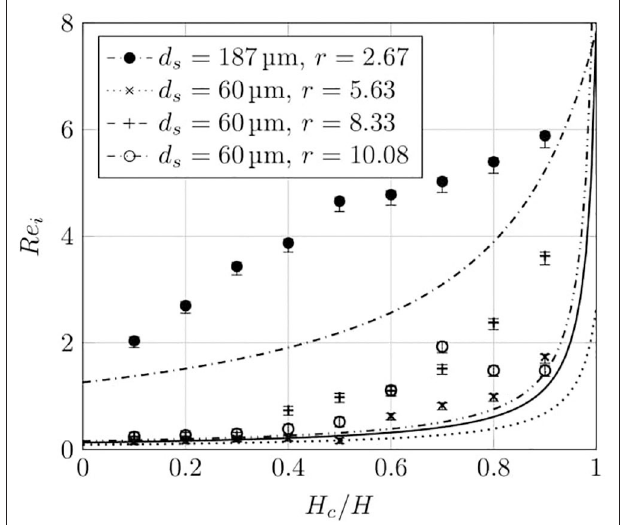
FIGURE 8 | Initiation Reynolds number as a function of H for the larger particles in two-layer fluidised beds consisting of a lower layer of particles with diameters 45–75 µ m and an upper layer of particles with diameters of 250–425 µ m for five H c / H values. The two black horizontal lines indicate the two Reynolds numbers corresponding to the minimum fluidisation velocities, u mff and u mfc , determined experimentally with mono-sized fluidised beds of each component with a depth of